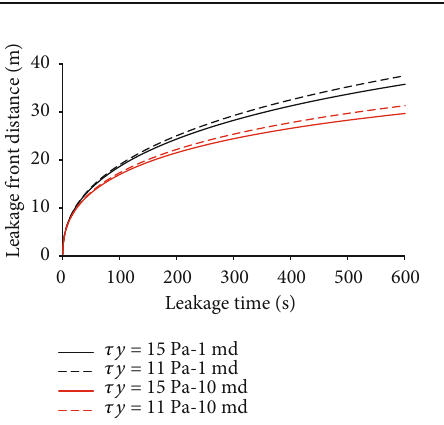
Figure 15: Leakage volume under di ff erent formation permeability and yield stress.